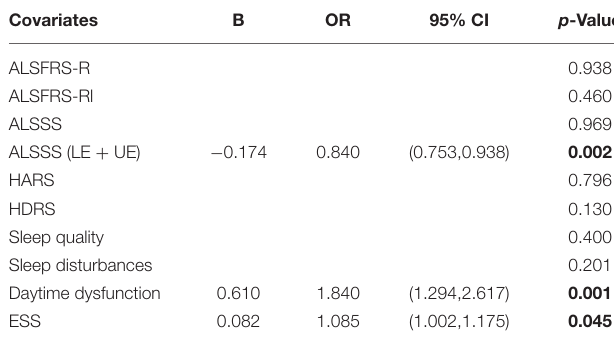
TABLE 3 | Differences in non-motor syndromes and quality of life between patients with ALS with fatigue and without fatigue. ALS patients with fatigue